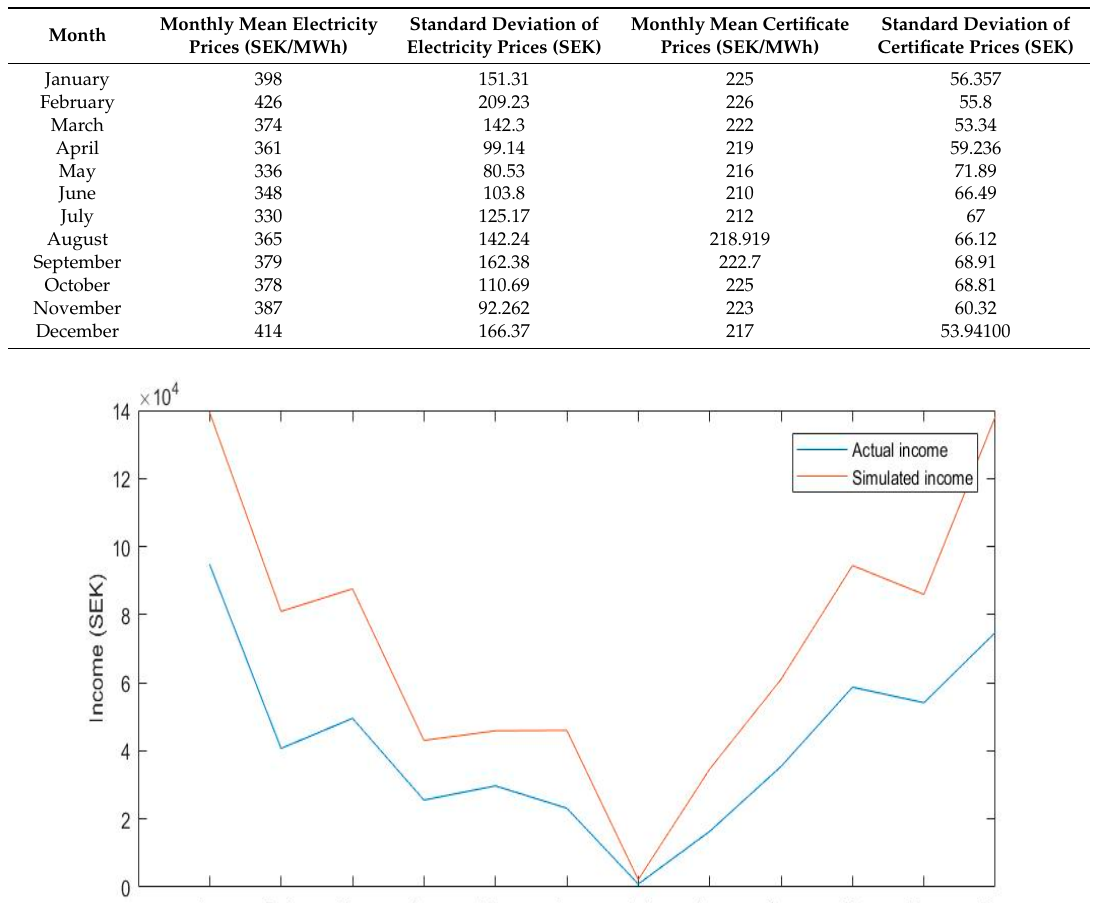
Table 7. Parameters for Monte-Carlo simulation.